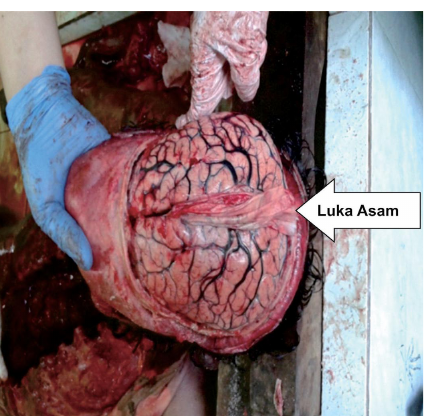
(Edema)Figure . Injury due to acid on the skin Figure . Injury due to acid in the glottis, esophagus and